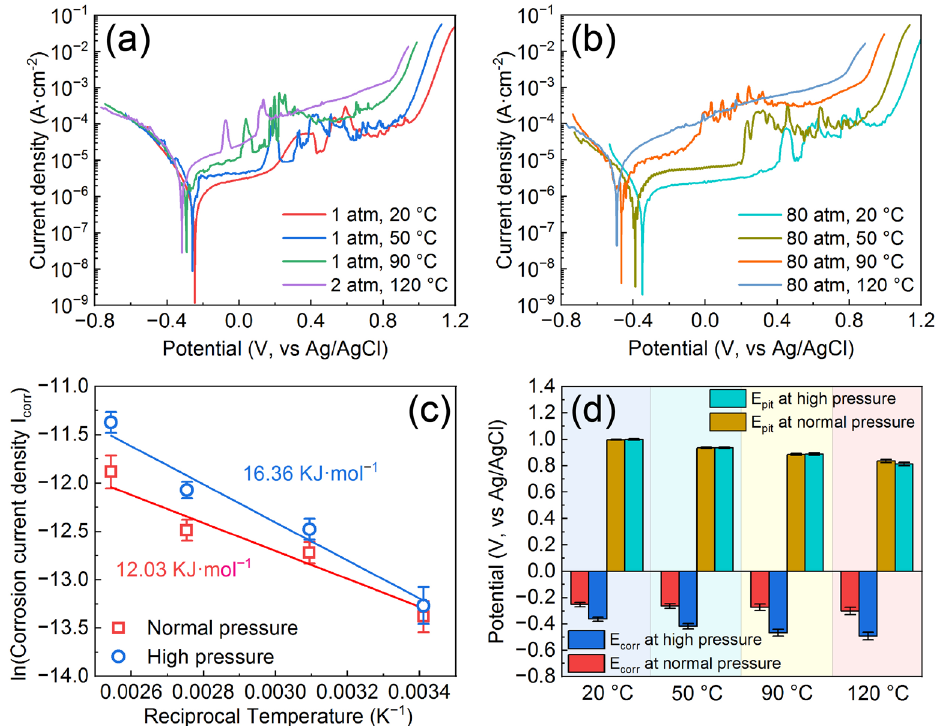
Figure 3. Potentio-dynamic polarization curves of the AMCs under normal pressure ( a ) and high pressure ( b ); ( c ) Arrhenius plots of the corrosion current densities of the AMCs at different pressures; ( d ) Corrosion potentials and pitting potentials of the AMCs under various temperatures and pressures.